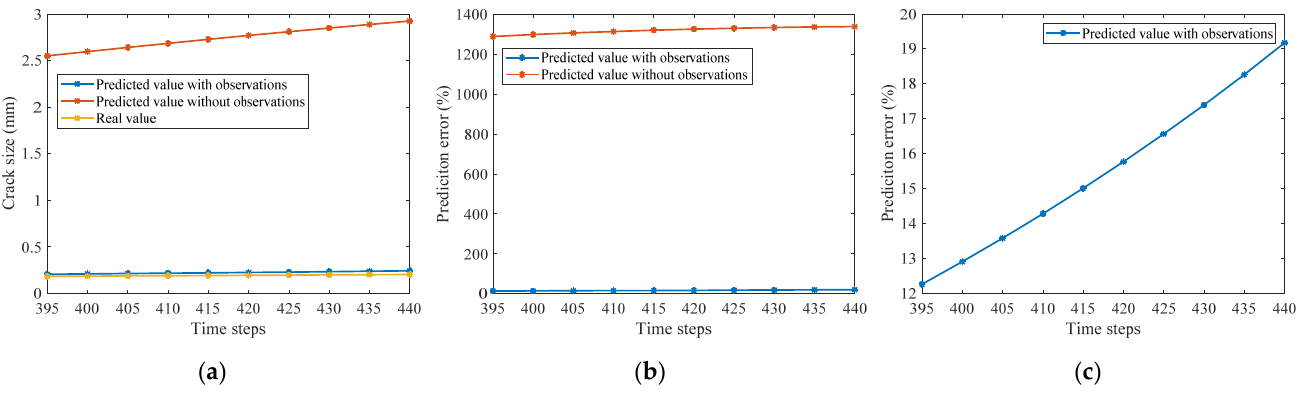
Figure 14. Comparisons of the prediction error of crack size with/without observation data. ( a ) Absolute prediction error. ( b ) Relative prediction error. ( c ) Zoom-in relative prediction error.